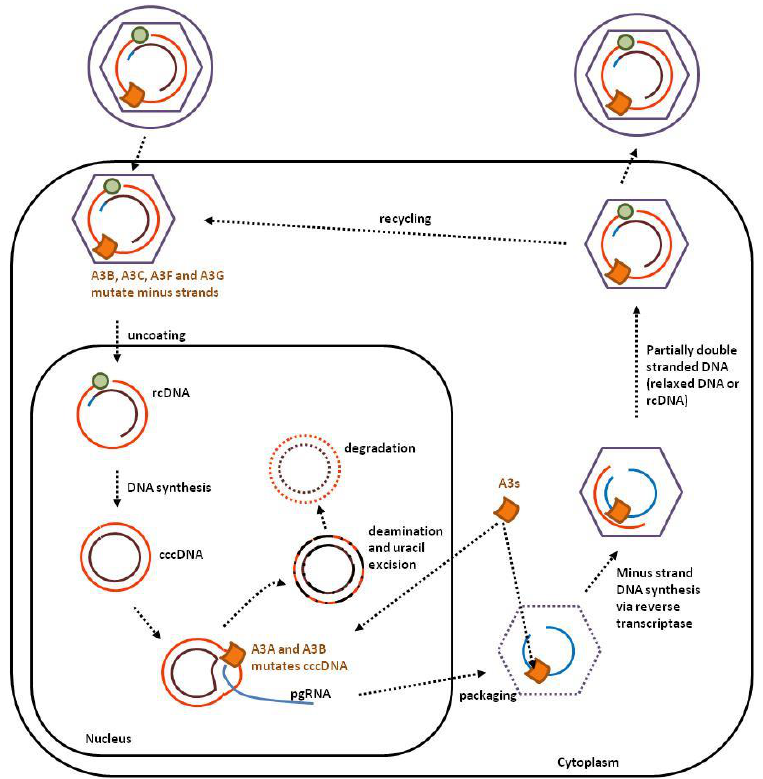
Figure 4. APOBEC3s interfere with several steps of the HBV replication cycle. The